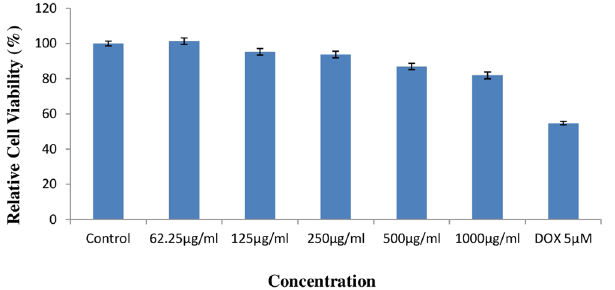
Figure 5. Effect of ethyl acetate extract of S. commune on Relative cell viability of CHO cell lines after treatment with different concentrations of ethyl acetate extract of